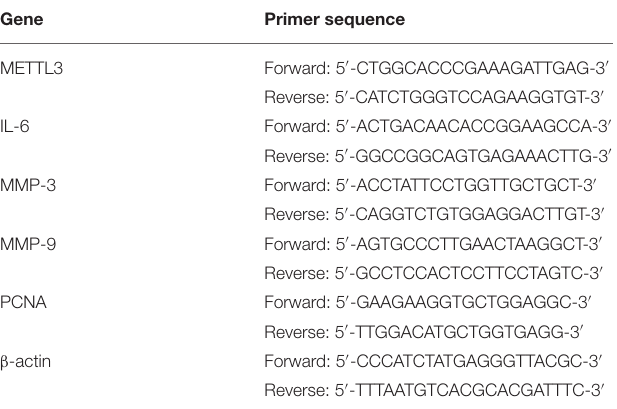
TABLE 1 | Primer sequences used in real-time quantitative PCR for rat genes.